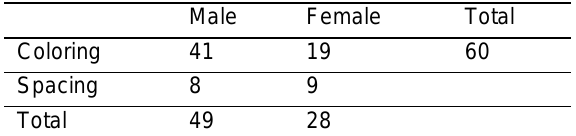
Table 5. Experience in Arabic